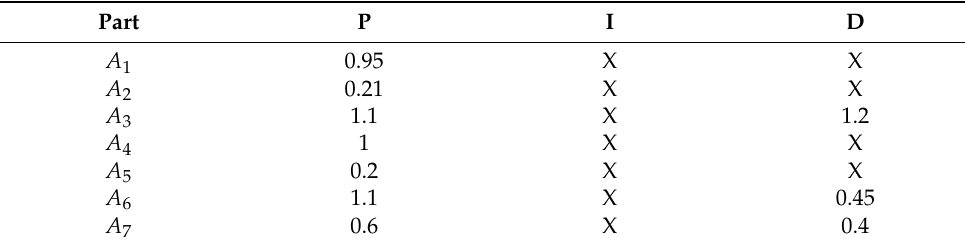
Table 4. Parameter for PID Control Scheme.